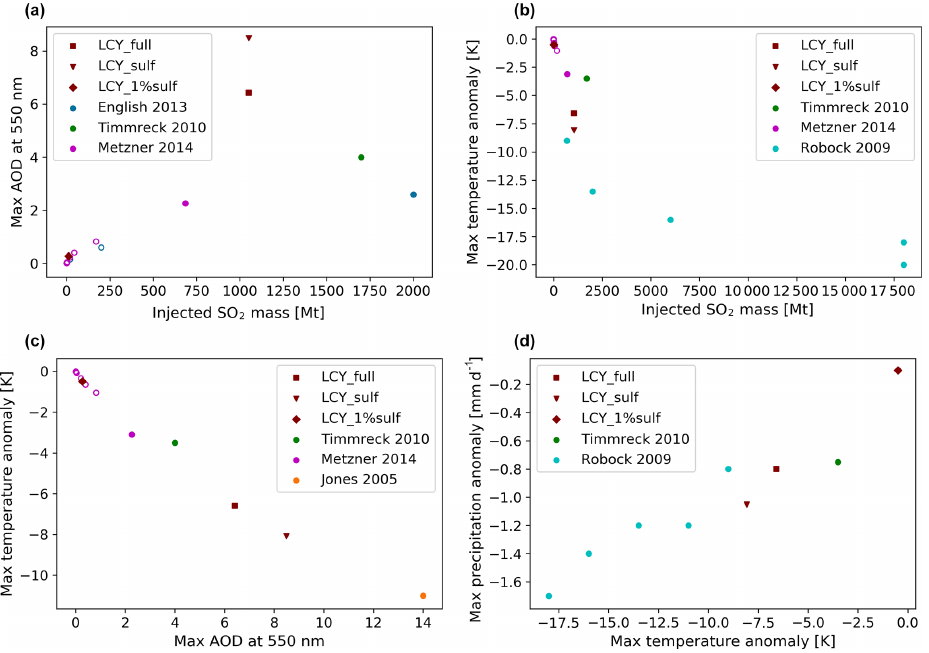
Figure 7. Scatterplots comparing our Los Chocoyos simulations to other supersized volcanic eruption simulations from Jones et al. (2005), Robock et al. (2009), Timmreck et al. (2010), English et al. (2013) and Metzner et al. (2014). Large to extremely large explosive eruptions not classified as supereruptions are marked with open